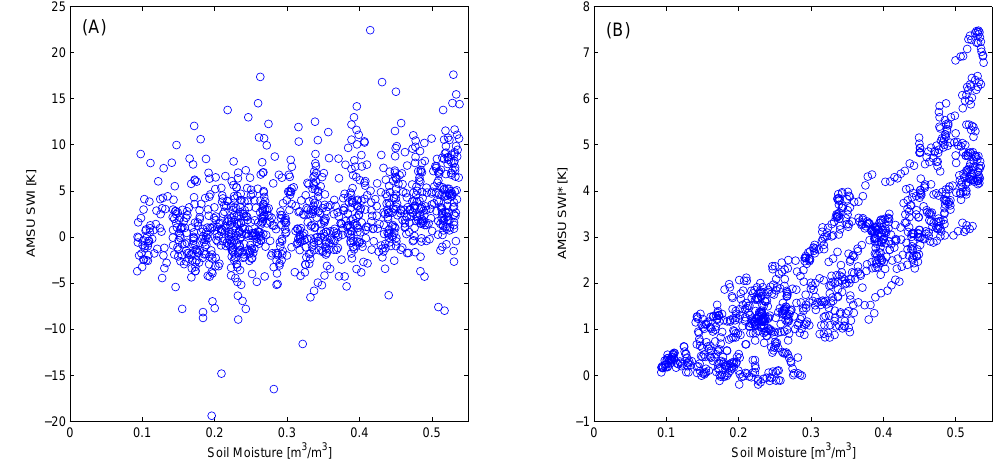
Fig. 5. (a) Comparison between SWI (K) and SM (m 3 m − 3 ) modeled by DREAM; (b) Comparison between SWI ∗ (–) and SM (m 3 m − 3 ) modeled by DREAM.